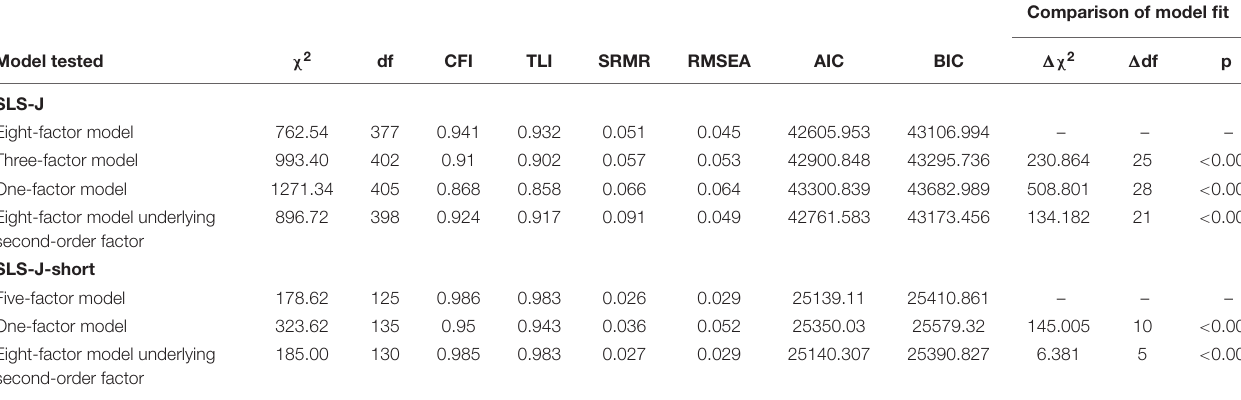
Comparison of model fit